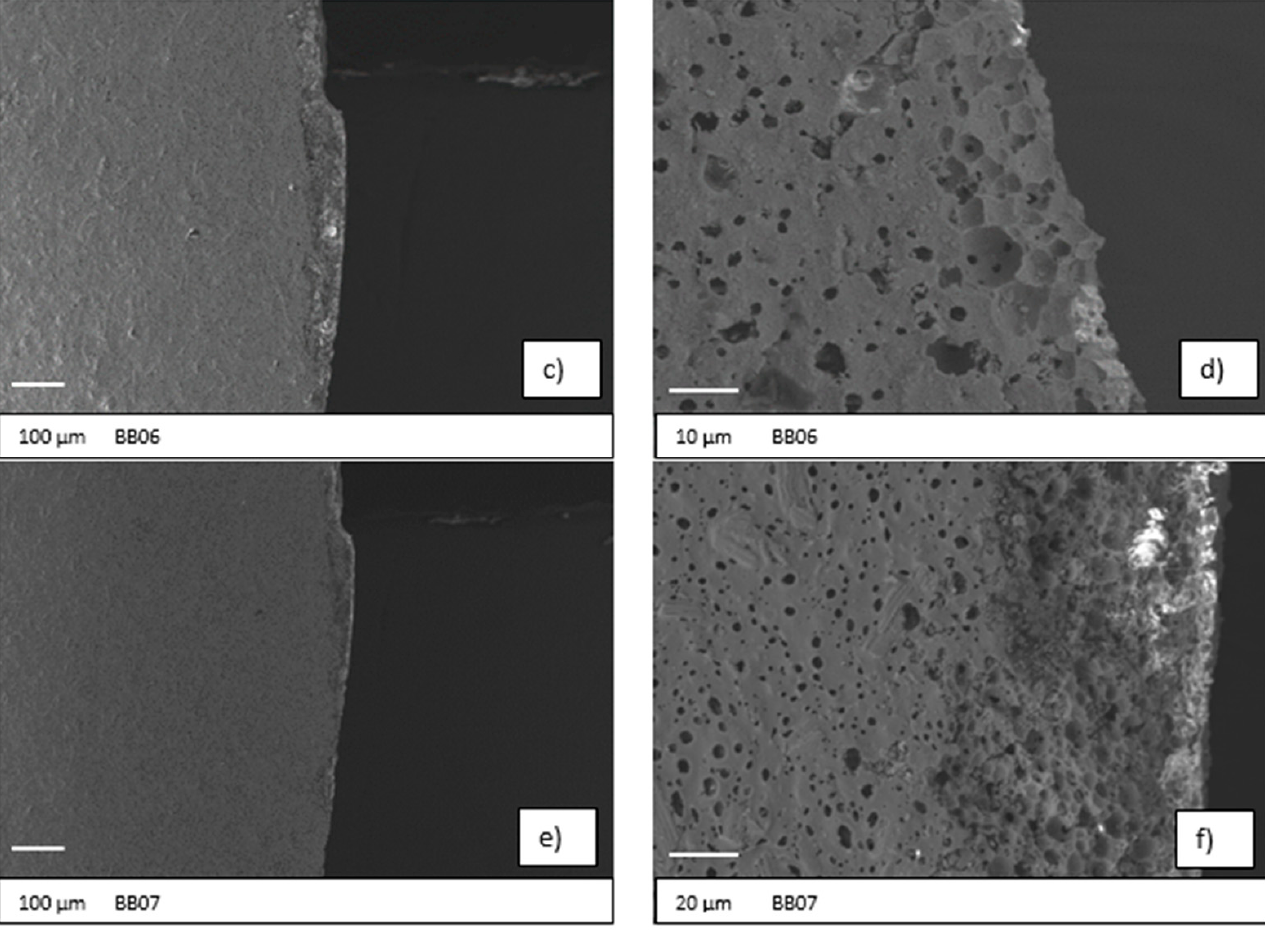
Figure 1. SEM images of the investigated samples.